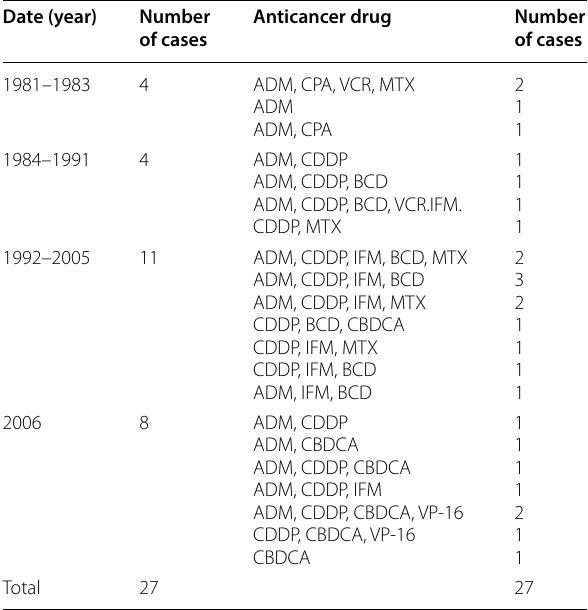
Table 2 Adjuvant chemotherapy pre- and